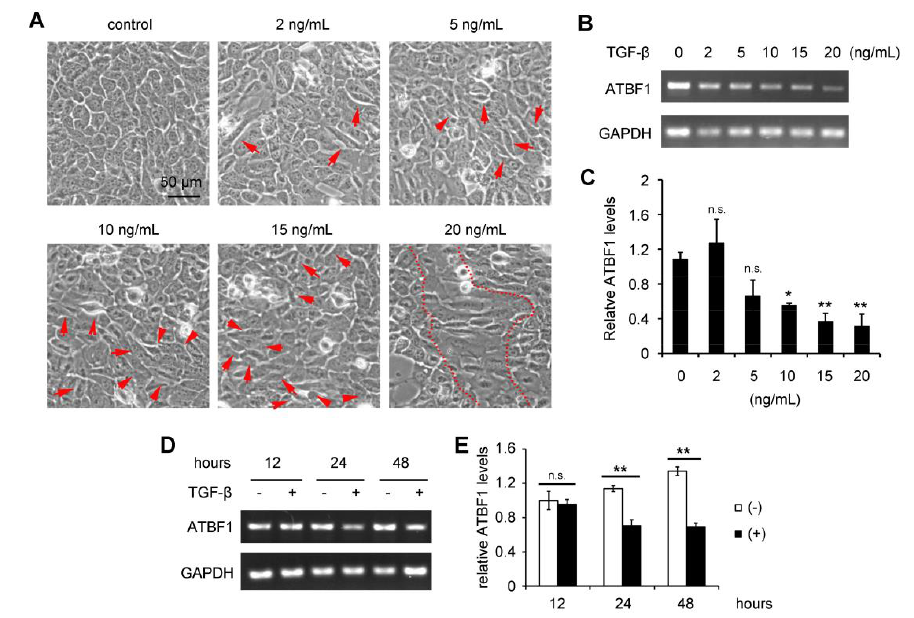
Figure 1. TGF-β reduced ATBF1 expression in a dose- and time-dependent manner, along with epithelial-mesenchymal transition (EMT) induction. HaCaT cell as a classic EMT modelwasintroduced. Cell morphology was imaged under a phase contrast microscope ( A ). by RT-PCR after TGF- β treatment at different concentrations ( B ) or different time points ( D ). The relative ATBF1 levels in different groups were quantified by ImageJ software ( C , E ). * p < 0.01; ** p < 0.001; n.s.,